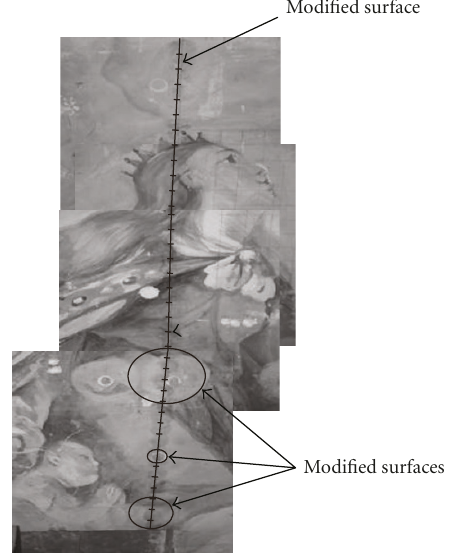
Figure 5: Photographic composition indicating the vertical array where the A-scans were collected, and the locations where some modifications were observed in the